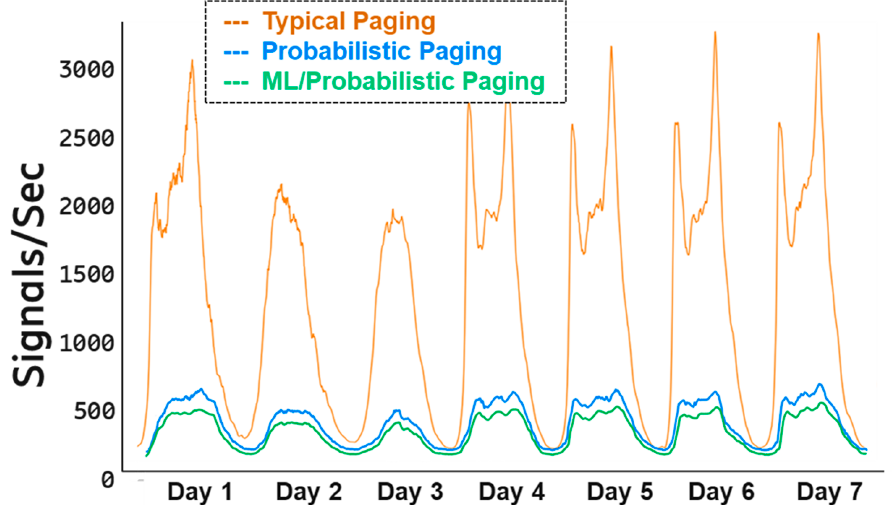
Figure 14. Paging signals observed daily for different conditions of paging system.